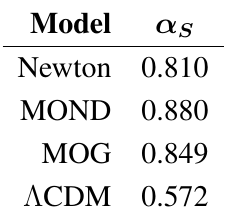
Table A2. Normalization factors for Equation